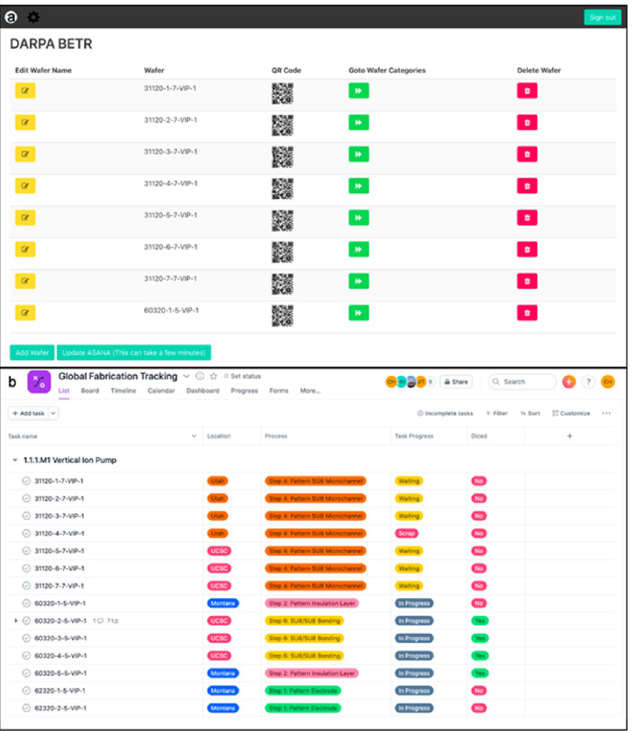
Fig 4. Application Overview (a) Application Tracking System that Integrates QR Codes and Asana, and (b) Asana Global Tracking System. Fig 4b provided through courtesy of